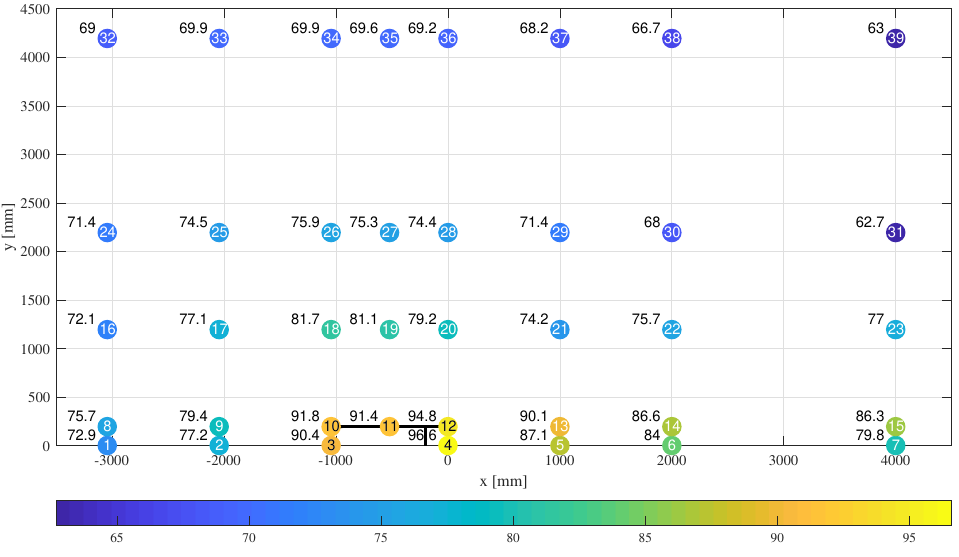
Figure 14. Overall sound pressure level in decibels (dBs) around the Ahmed body, measured at receivers for the z-coordinate of 194 mm. View from the top.